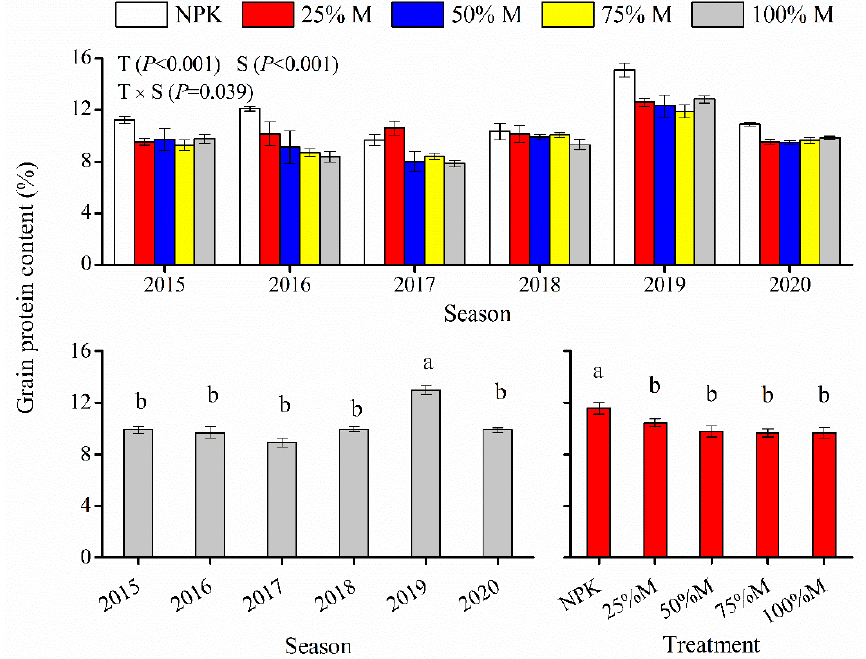
Figure 5. Wheat grain protein content under different treatments of winter wheat–summer maize cropping system during 2014–2020. Bars represent standard error. Different letters above bars are significantly different between treatments or years at P < 0.05.